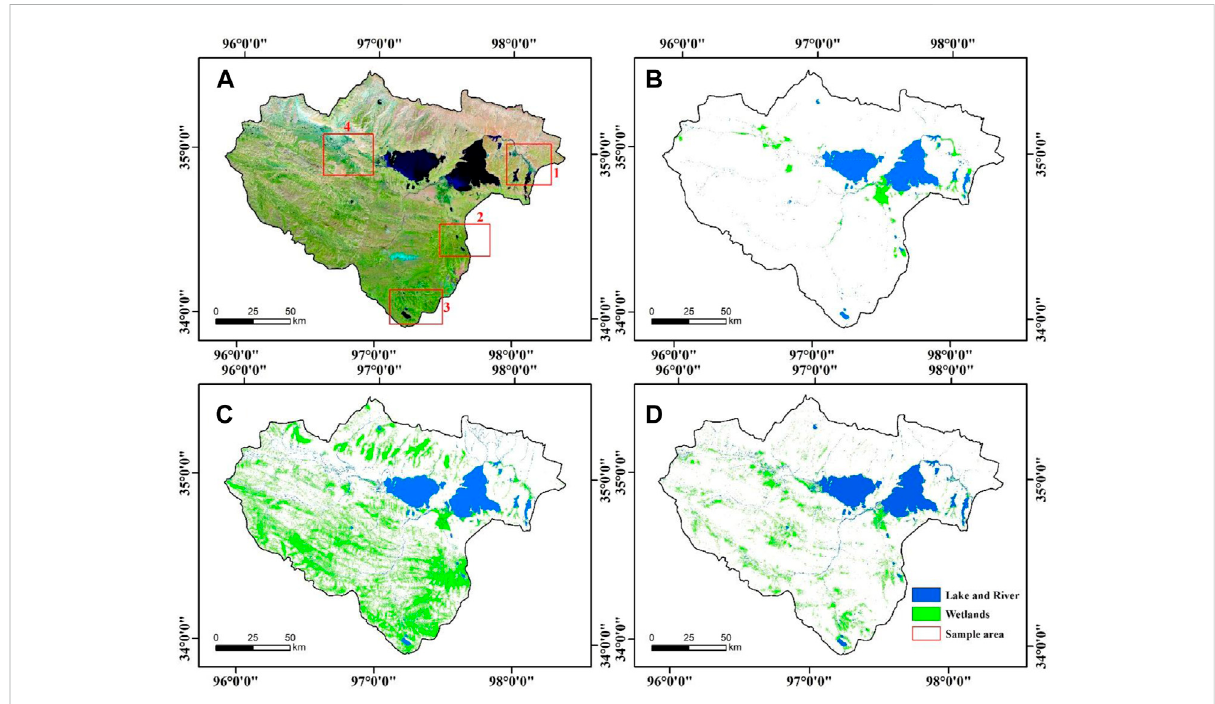
Wetland maps for the headwater area of the Yellow River from different datasets (A) . Landsat OLI color composite (bands 7, 5, 3) (B) GLC wetlands. (C) CAS_wetlands. (D) Object-oriented combined with decision tree wetland extraction results (this